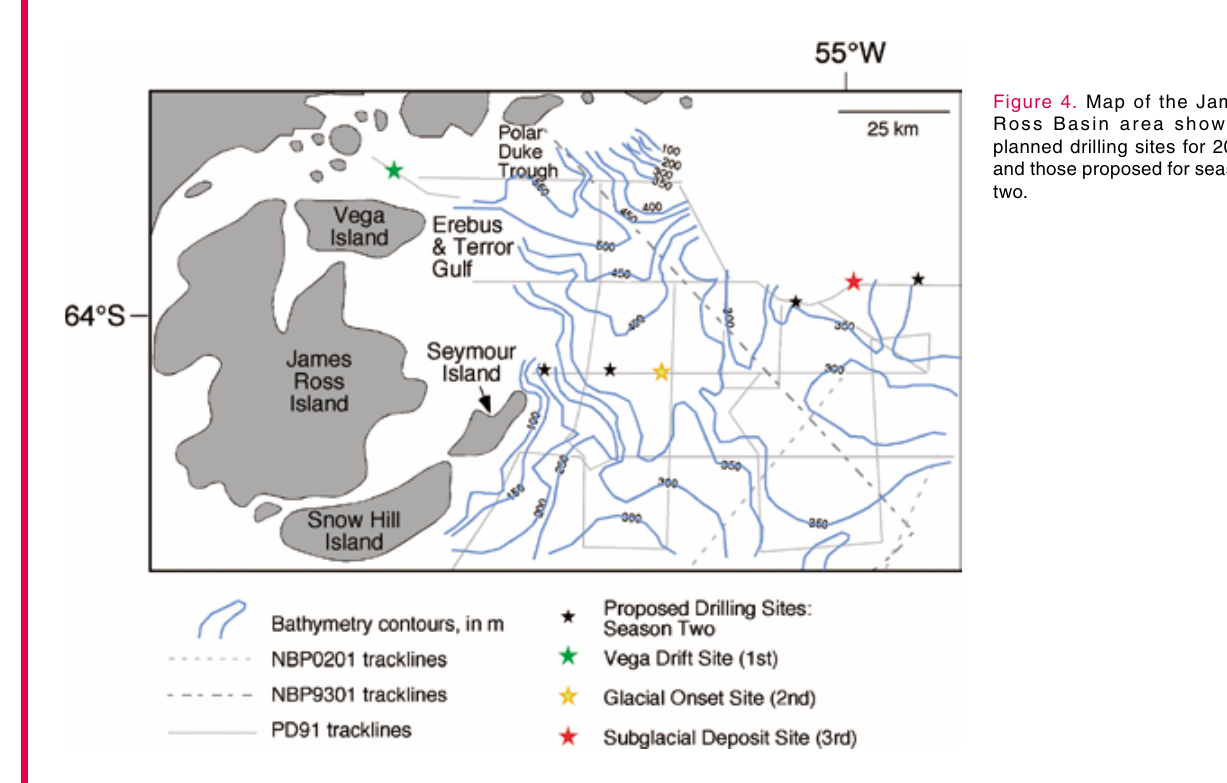
Figure 4. Map of the James Ross Basin area showing planned drilling sites for 2005 and those proposed for season